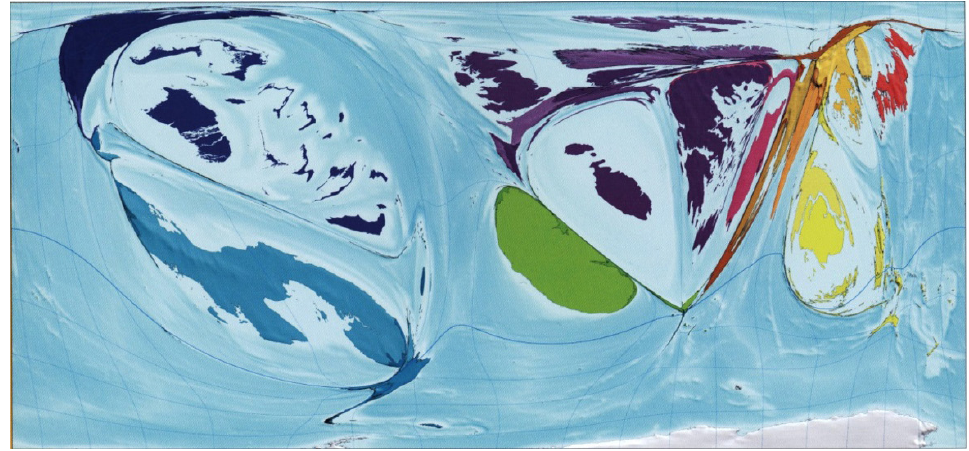
Fig. 6. Irregular cartogram (Gastner-Newman) – the distortions mainly concern hard-to-recognize countries. Number of tankers by country